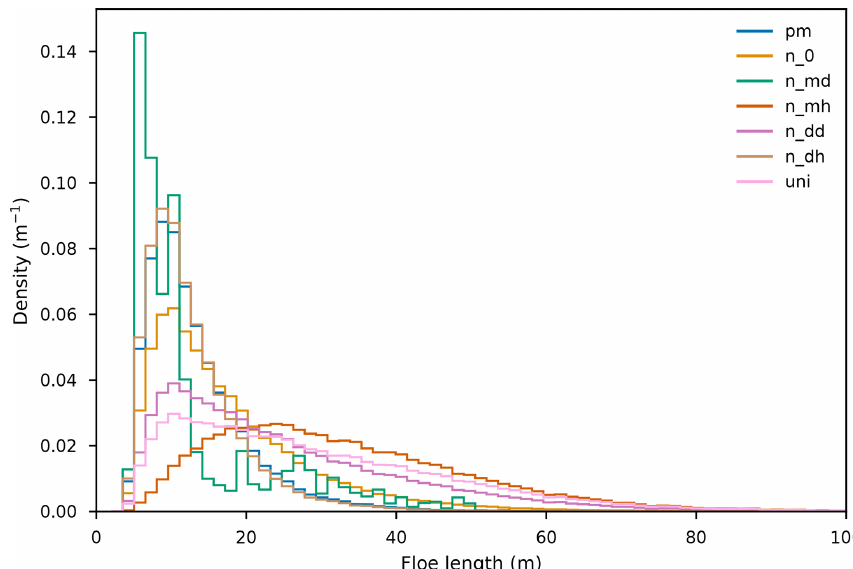
Figure B2. Densities obtained when combining monochromatic model runs with different weighting functions, as represented in Fig. B1.